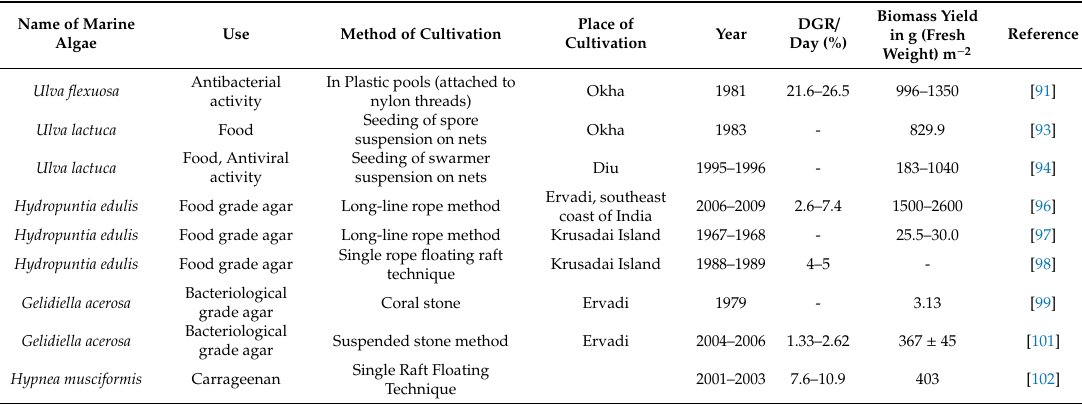
Table 3. Economical important seaweeds and their cultivation in